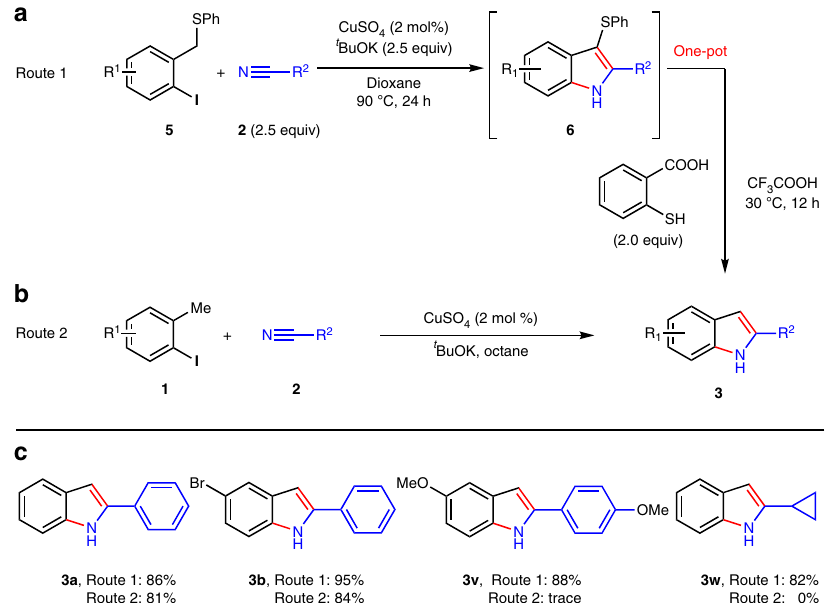
Fig. 6 Comparison between the synthesis of 3 from 1 and that from 5 . a Synthesis of 3 using a one-pot cyclization-deprotection from 5 . b Synthesis of 3 from the cyclization of 1 and 2 . c Comparison between Route 1 and Route 2